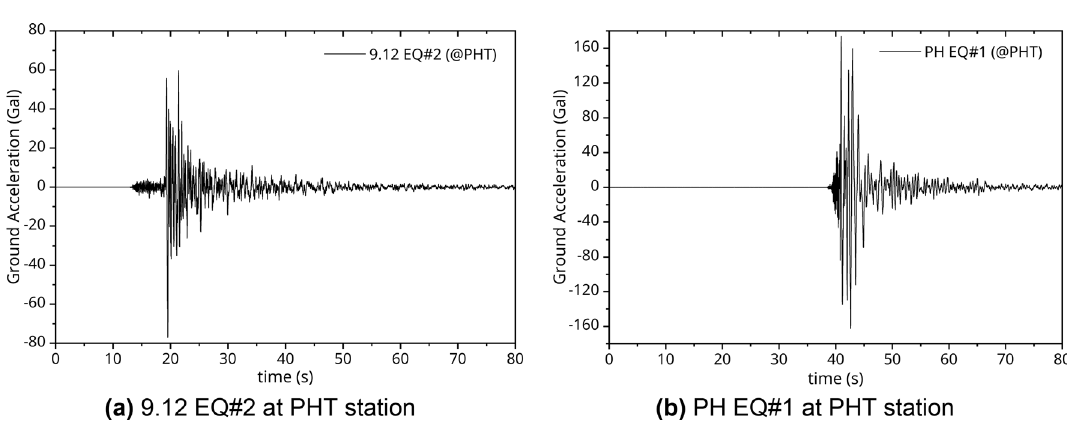
Figure 3. Wave time series for E-component at PHT according to the